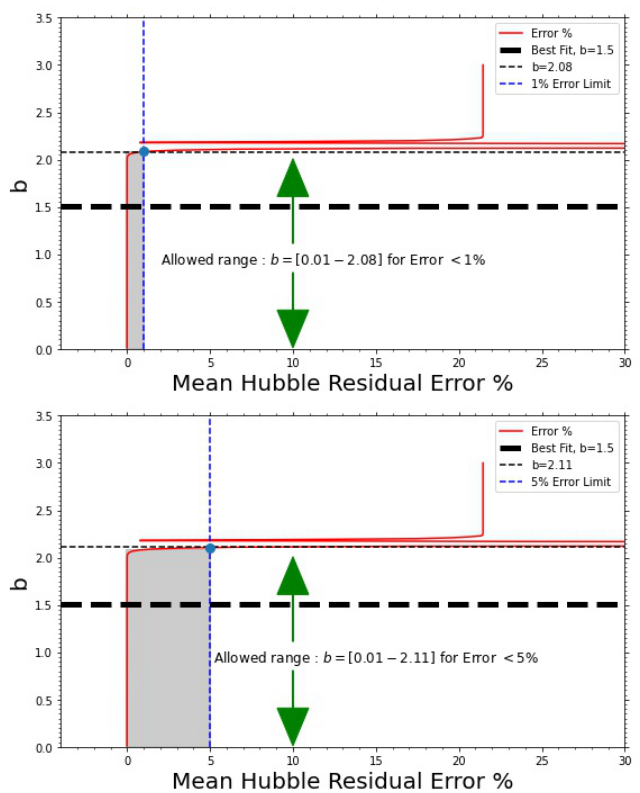
Figure 2. ( Up ): 1% error. ( Down ): 5% error limit. The red line shows the error percentage against the b value. The blue dashed horizontal line marks the two corresponding levels of error margin. The grey shaded region marks the allowed range of b values for which the error level will be either ≤ 1% or ≤ 5%. The horizontal black dashed line marks the maximum limit of the b value. The thick black horizontal line shows the best fit b